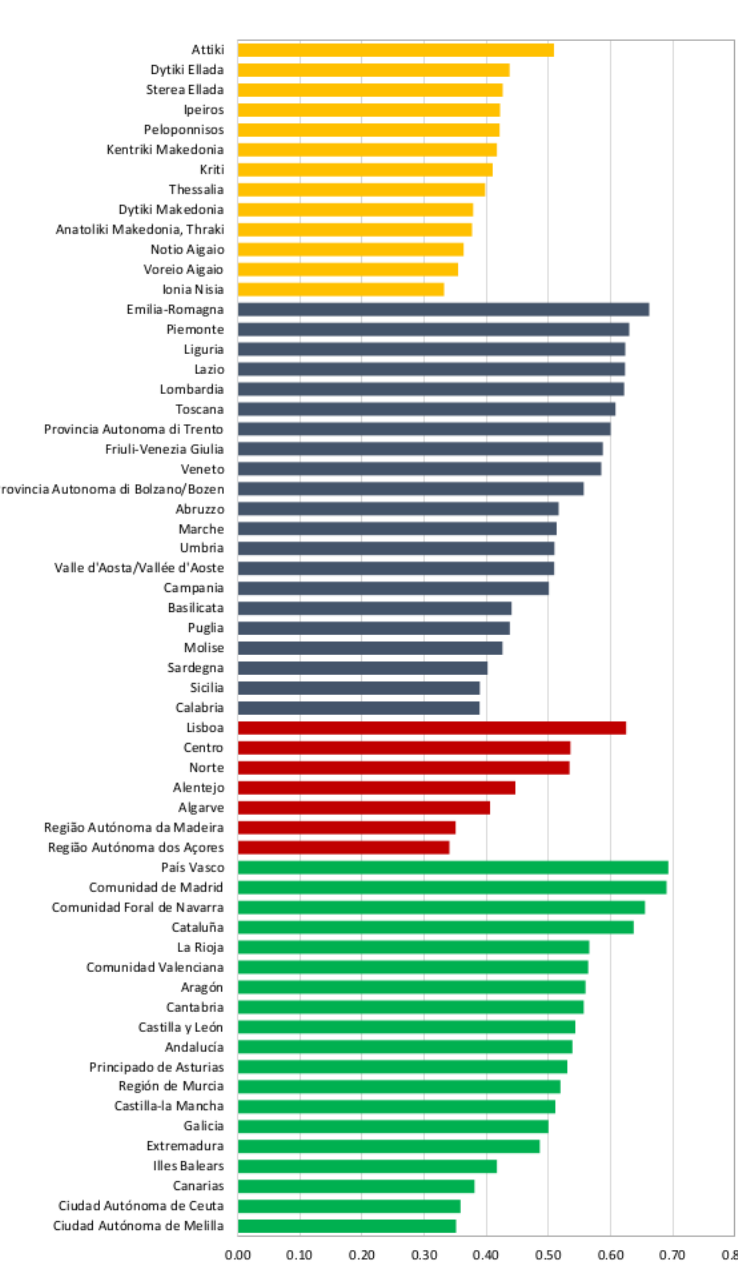
Figure A.1: The Economic Indicator of the south European regions